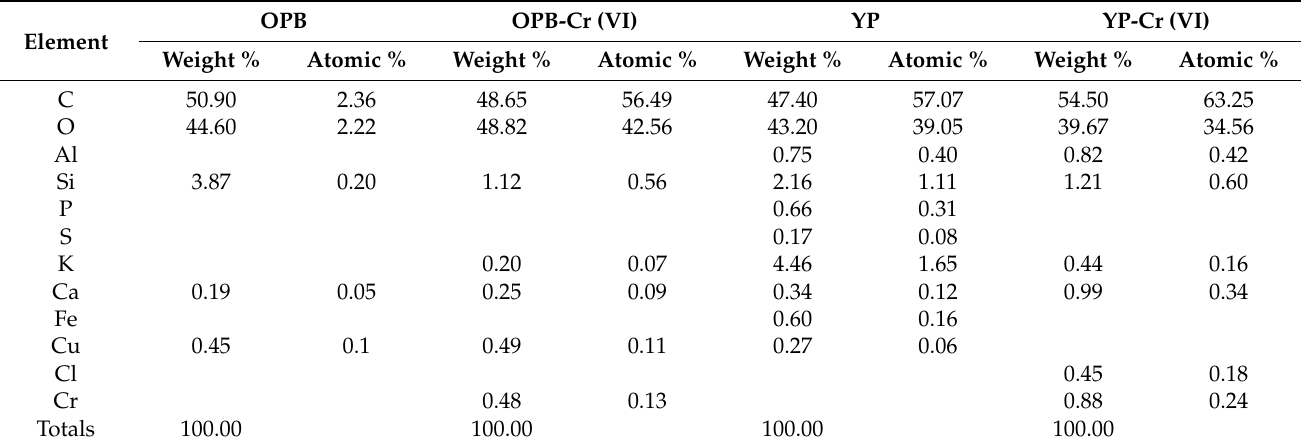
Table 3. EDS composition analysis.